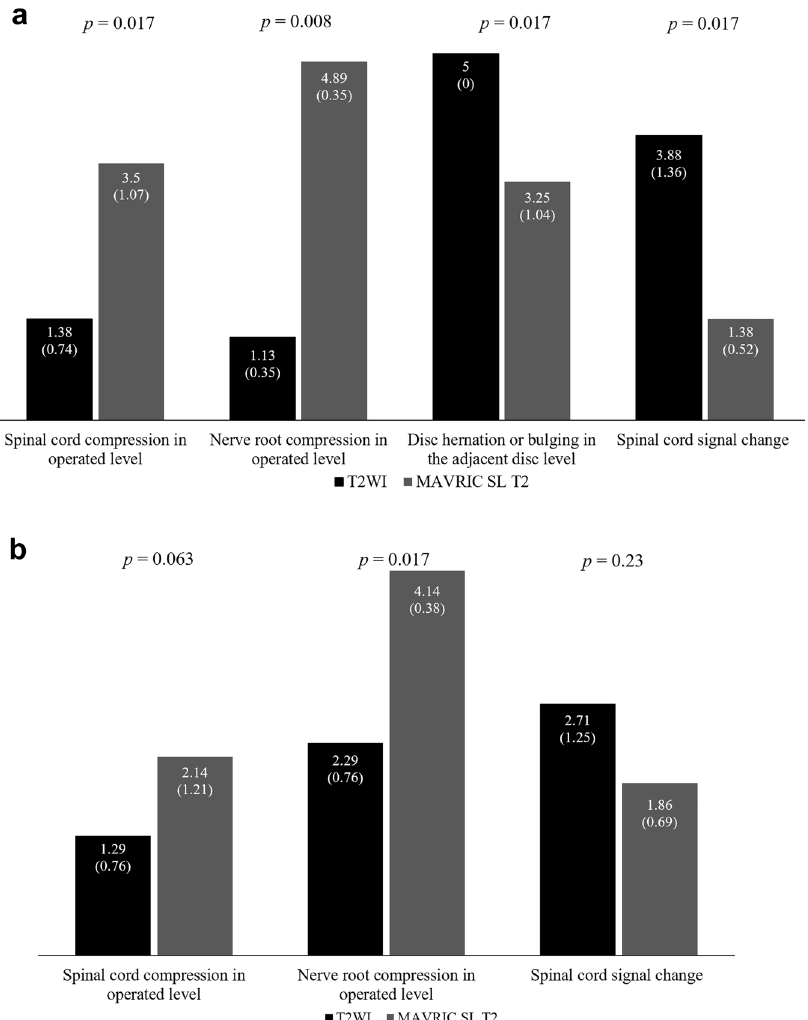
Figure 4. Average scores of the consensus reading for clinical usefulness of T2-weighted sequence (T2WI) and multiacquisition with variable resonance image combination selective T2-weighted sequence (MAVRIC SL T2) in the sagittal ( a ) and axial planes ( b ). Numbers on the top of the bar are the average score and the numbers in parentheses for each bar are the standard deviation. The p value for each category is noted at the top of the graph.